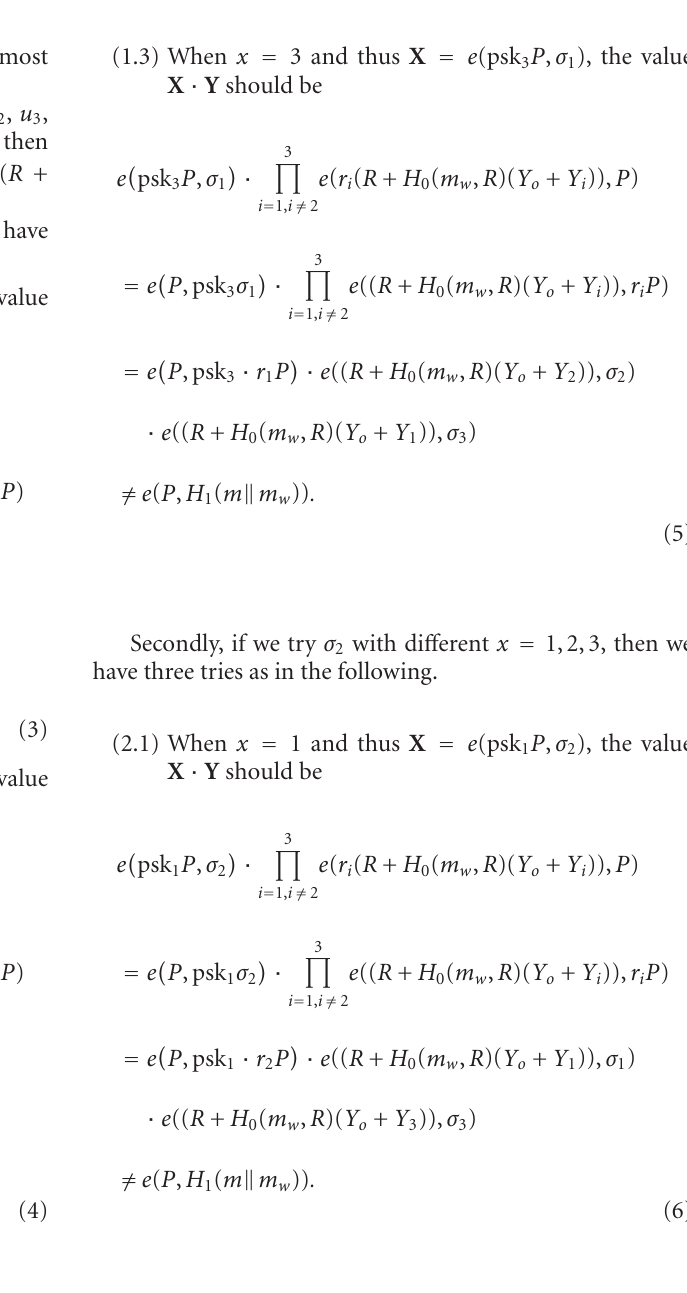
Figure 2: APS generation phase and the APS verification phase of Yu et al.’s